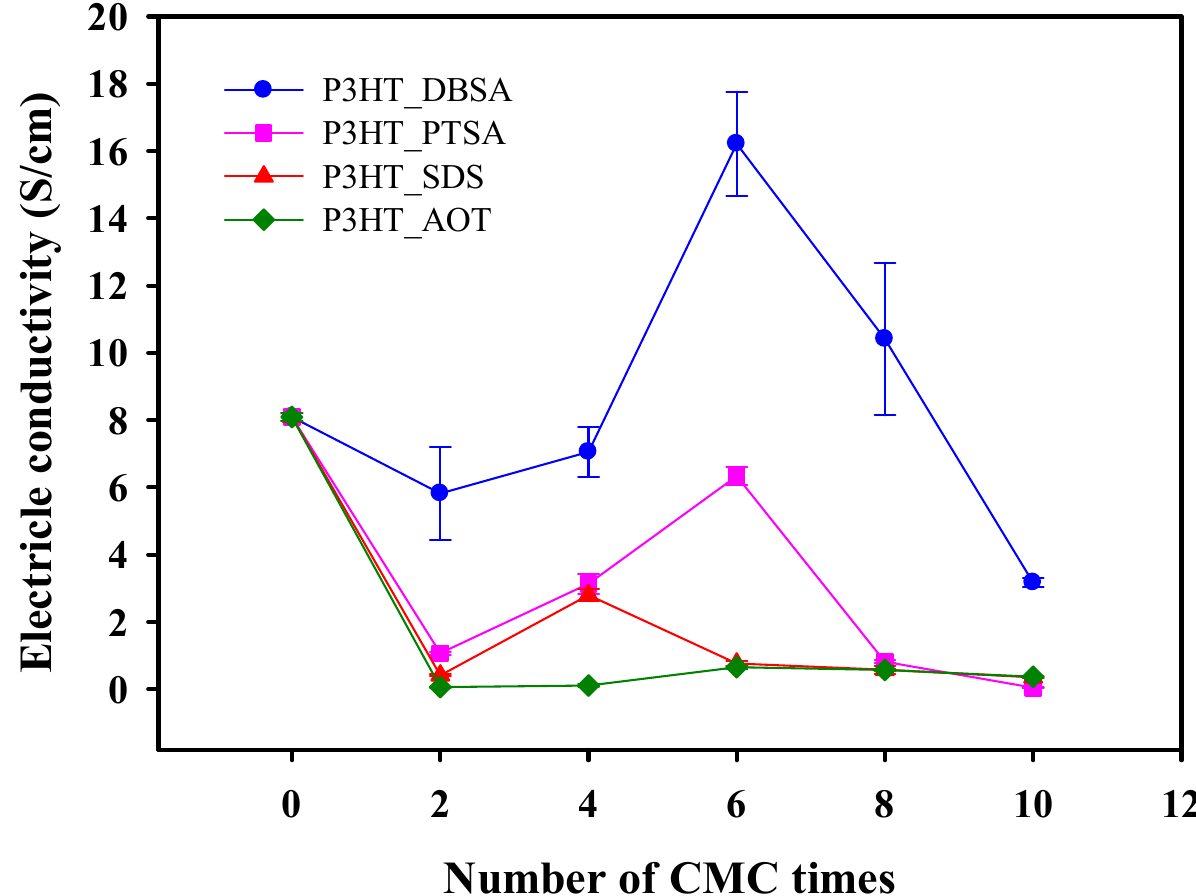
Figure 6. Electrical conductivity of P3HT synthesized by chemical oxidative polymerization with various surfactants at the monomer to oxidant ratio of 1:3 and at the polymerization time of 12 h.